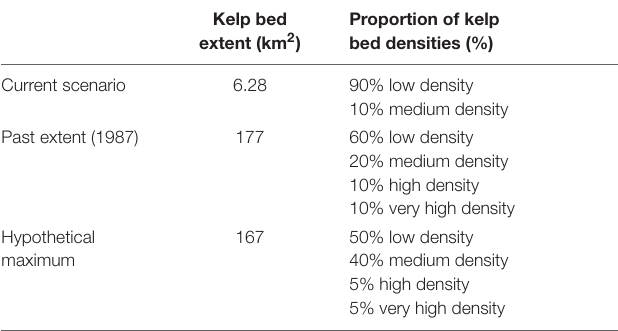
TABLE 3 | Kelp bed extent and densities for each